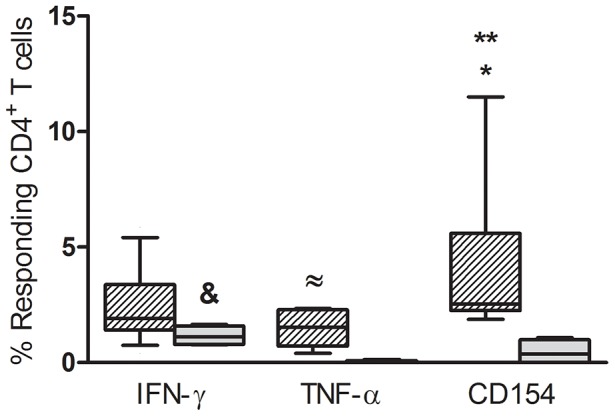
Magnitude of CD4+ T cell responses in T. cruzi-infected children and adults.Whole blood was stimulated with an amastigote lysate preparation, and antigen-responsive CD4+ T cells were measured using an intracellular staining assay for IFN-γ, TNF-α and CD154. The percentage of total responsive CD4+ T cells for each individual function in nineteen T. cruzi-infected children (hatched columns) and ten adults with chronic T. cruzi infection (black columns) is plotted. Boxes and whiskers depicting median and 10th and 90th percentile values are shown. (*) P = 0.03 vs. CD4+TNF-α+ in T. cruzi-infected children and (&) P = 0.03 vs. CD4+TNF-α+ T cells in T. cruzi-infected adults by Kruskal-Wallis test with Dunn correction; (**) P = 0.004 vs. CD4+CD154+ in T. cruzi-infected adults and (≈) P = 0.006 vs. CD4+TNF-α+ T cells in T. cruzi-infected adults by Mann-Whitney U test.